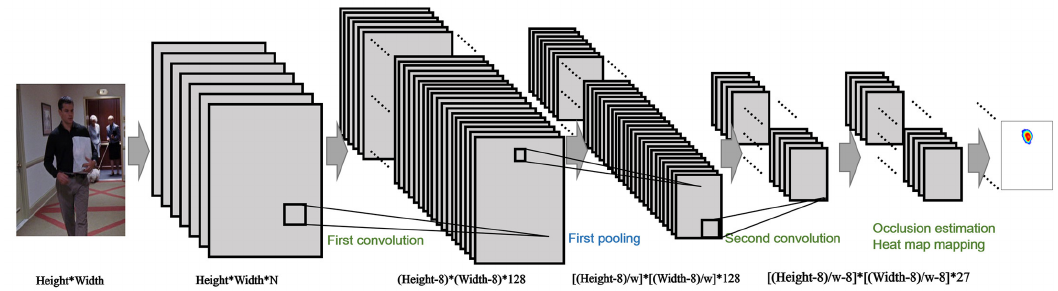
Figure 2. The structure schematic of the deep model at the low level. With two convolution and pooling layers, the scores are mapped to the heat map, which indicates the possible joint distribution of the input